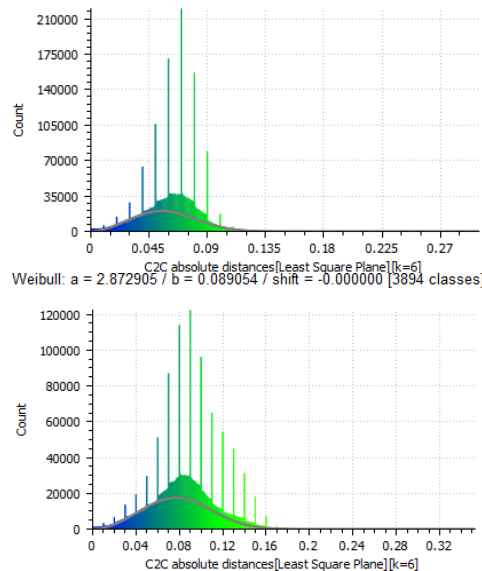
Figure 9: Distribution of the cloud-to-cloud distances between the LiDAR and AT (top) and the LiDAR and DG (bottom) DTMs plotted against the Weibull distribution